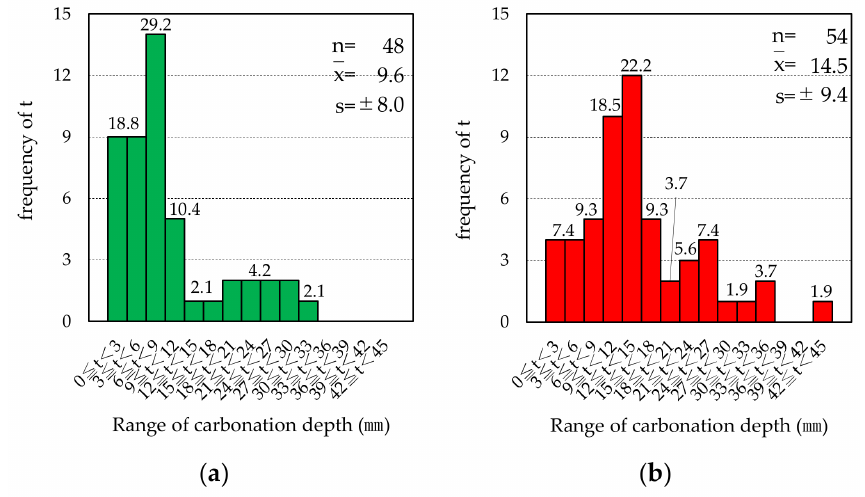
Figure 10. Distribution of carbonation depth of Bldg. A. ( a ) NE wall with external insulation, ( b ) NE wall without external insulation.